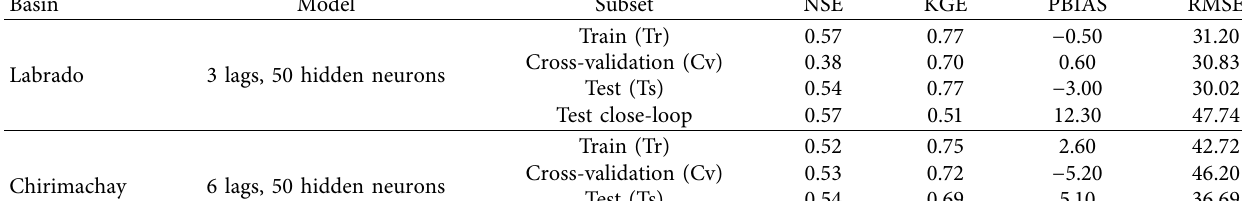
Table 5: Results for NARX net models.